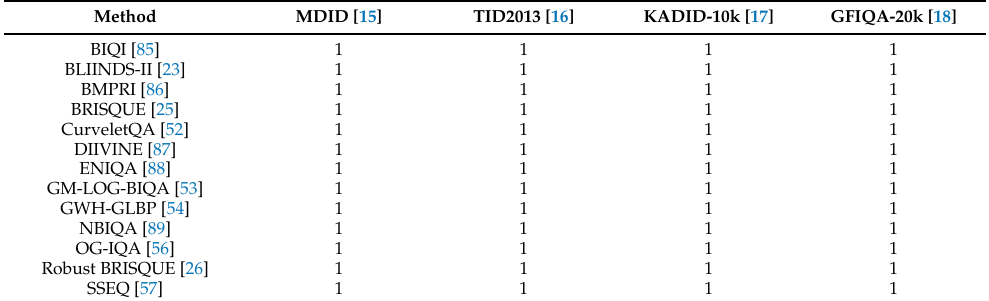
Table 10. Results of the two-sided Wilcoxon rank sum significance tests on MDID [15], TID2013 [16], KADID-10k [17], and GFIQA-20k [18]. The symbol ‘1’ denotes that SGL-IQA provided significantly better results than the method represented in the row on the database represented in the